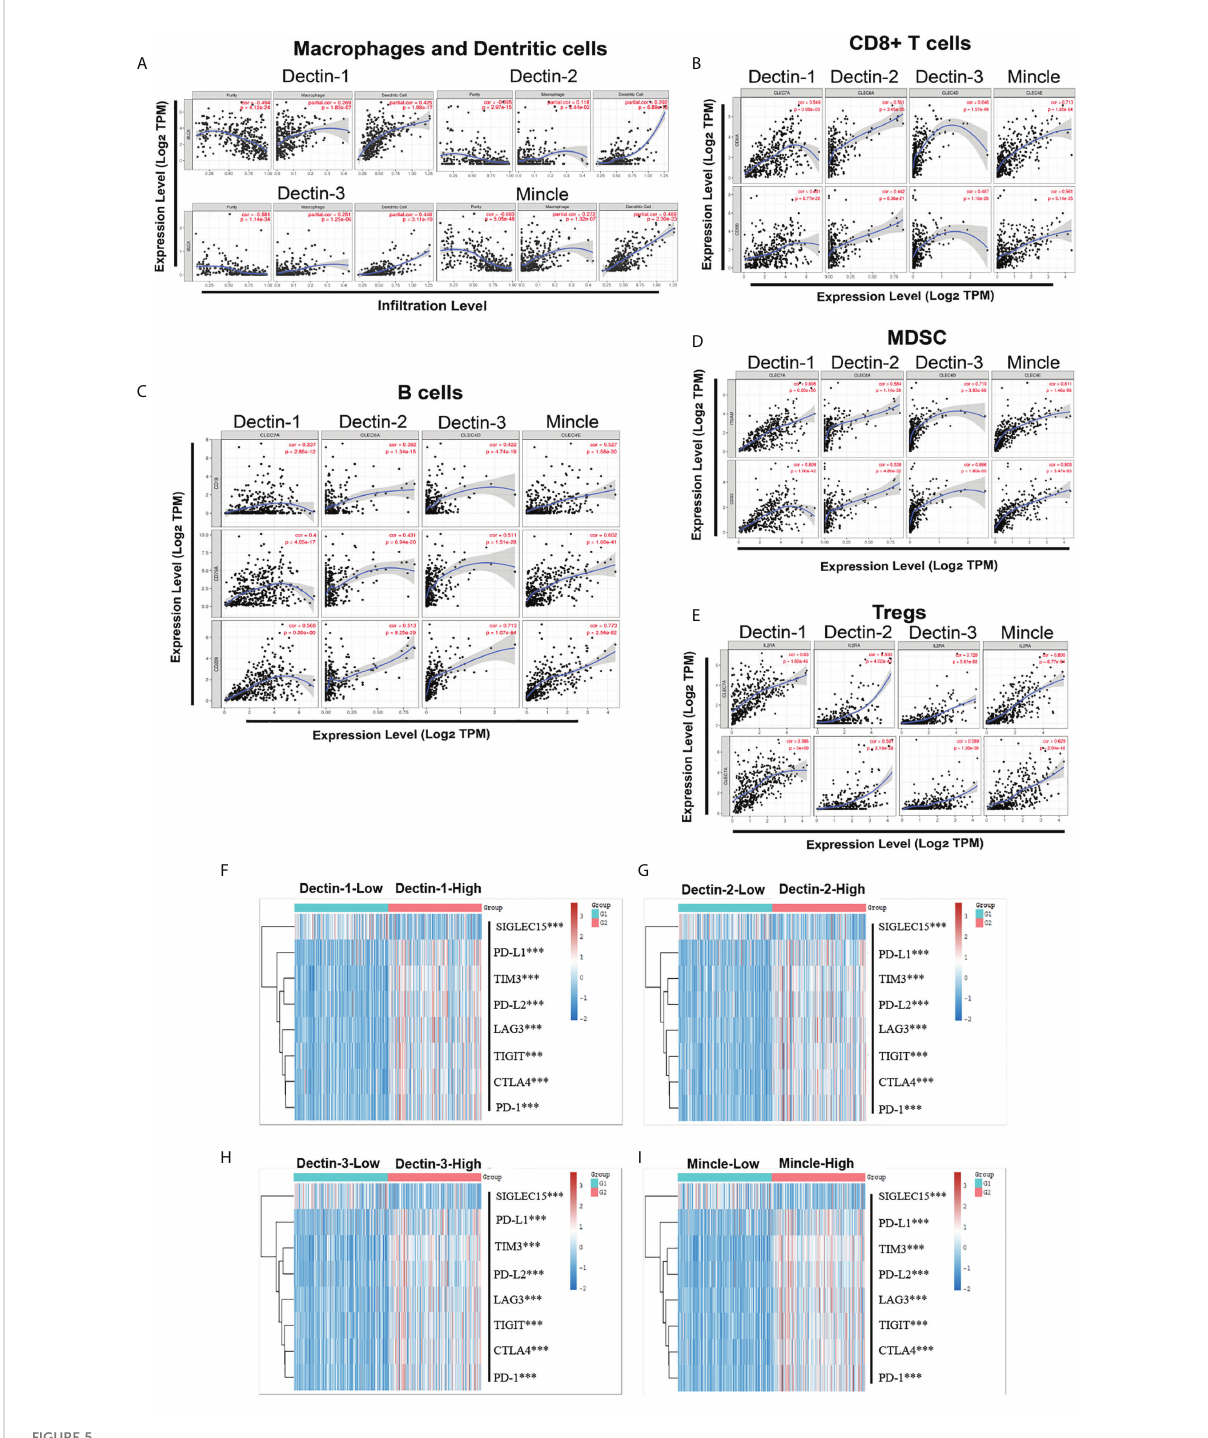
FIGURE 5 Association between CLR expression and multiple crucial immune cell in fi ltration in bladder cancer, including macrophages, neutrophils, and dendritic cells (A) , CD8+ T cells (B) , B cells (C) , MDSCs (D) , and regulatory T cells (Tregs) (E) . Comparison of the expression of the crucial immune-checkpoint molecules between bladder cancer patients in the CLR-low group and the CLR-high group (F – I) . The colors represent the trend of gene expression in different samples. * p < 0.05, ** p < 0.01, *** p < 0.001. The statistical differences between the two groups were compared using a Wilcox